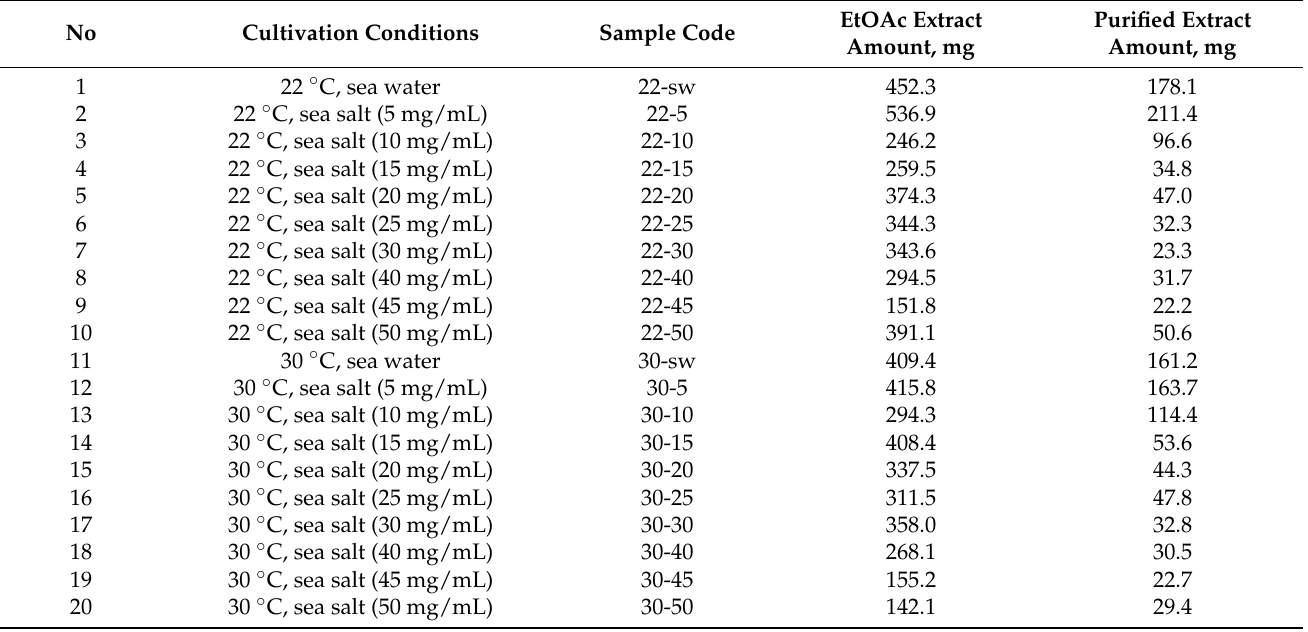
Table 1. Cultivation conditions of Penicillium dimorphosporum KMM